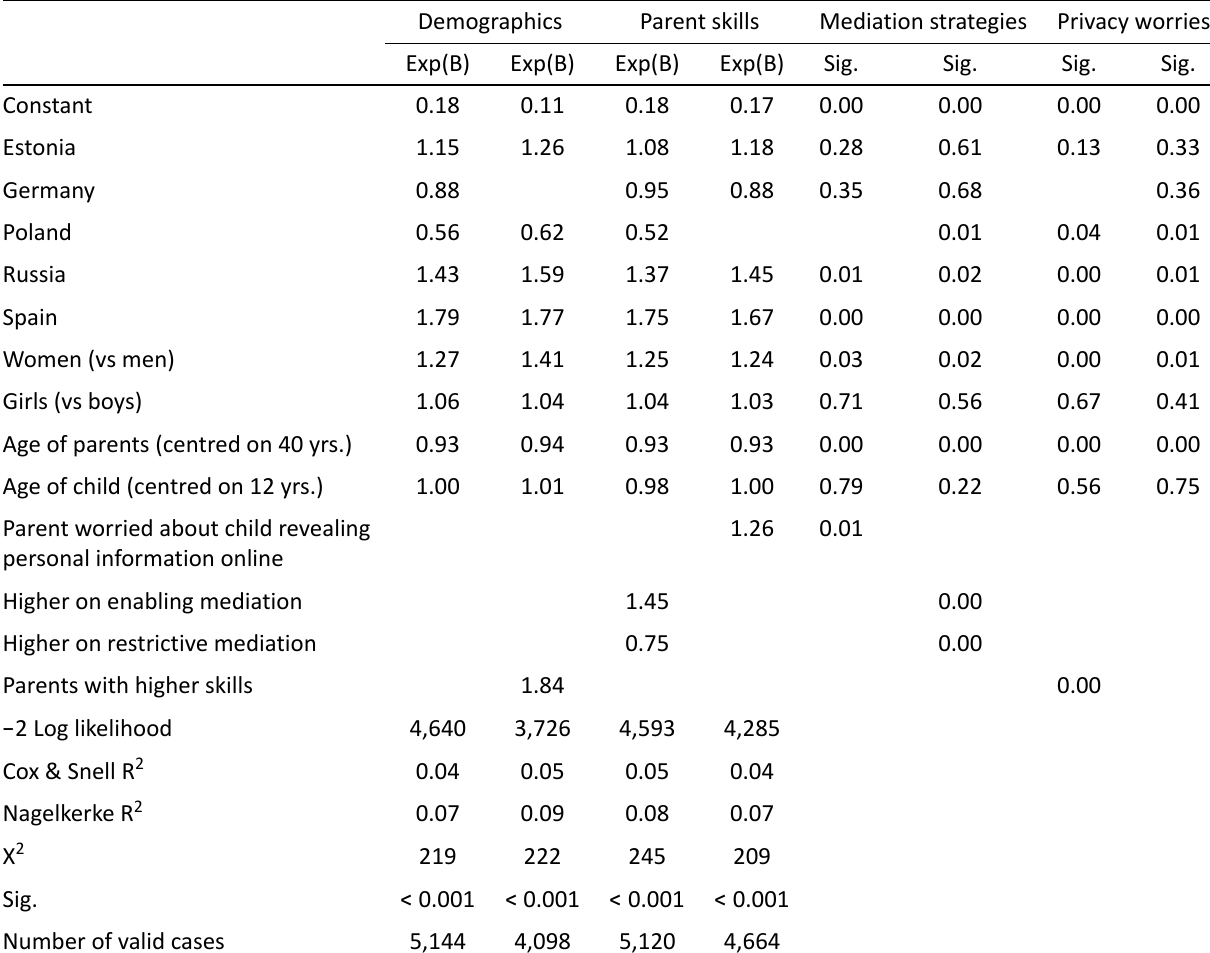
Table 5. Logistic regression models predicting the likelihood of a parent being a frequent sharer of